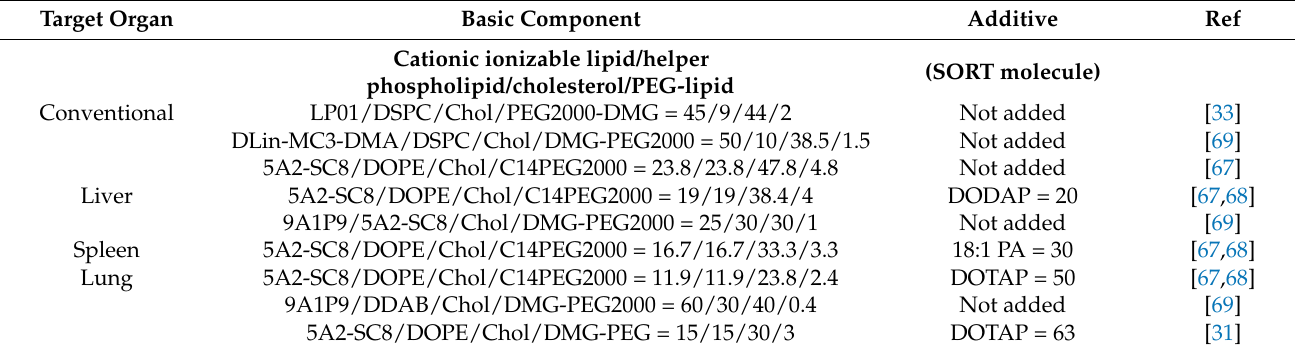
Table 6. Tissue targeting of